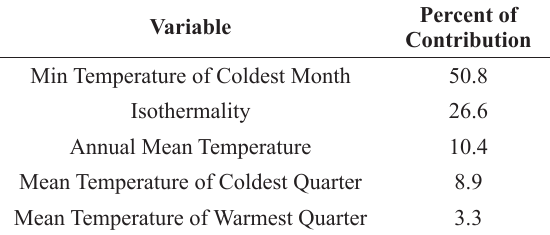
Most influential current climatic variables determining the occurrence areas of Schinus molle in the globe, after exclusion of correlated* and less influential (< 1%)